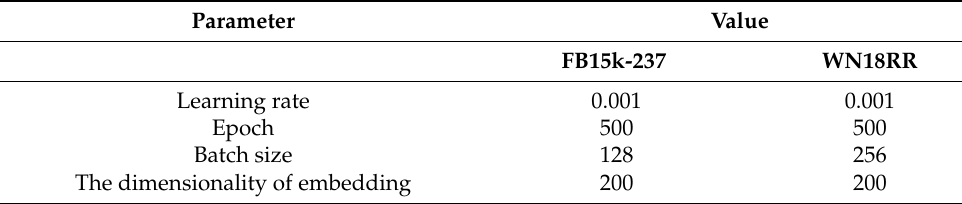
Table 5. Hyperparameter settings of our